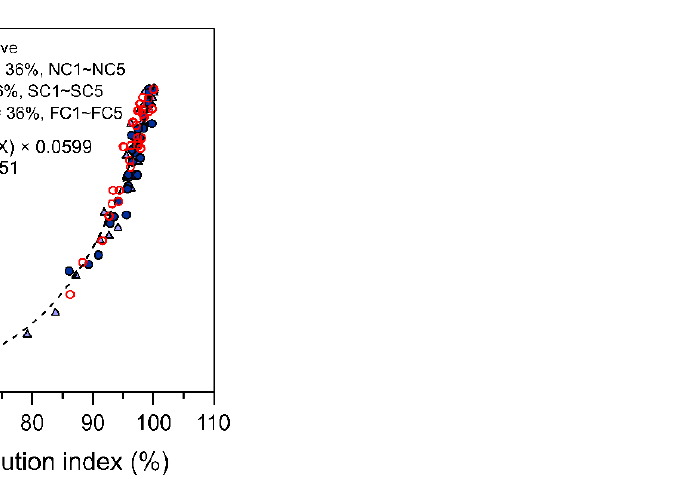
Figure 7. Relationship between the UPV and strength evolution index of normal and pozzolanic concrete.